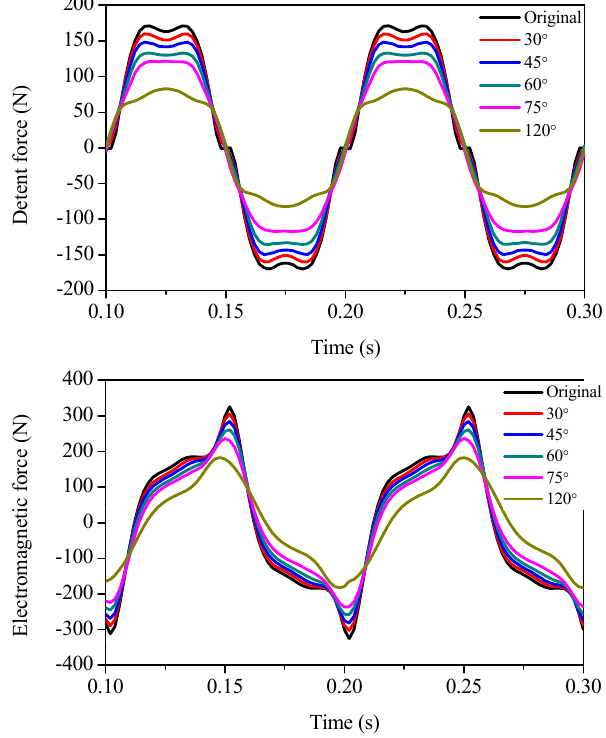
Figure 4. Output power for different skewing angles.